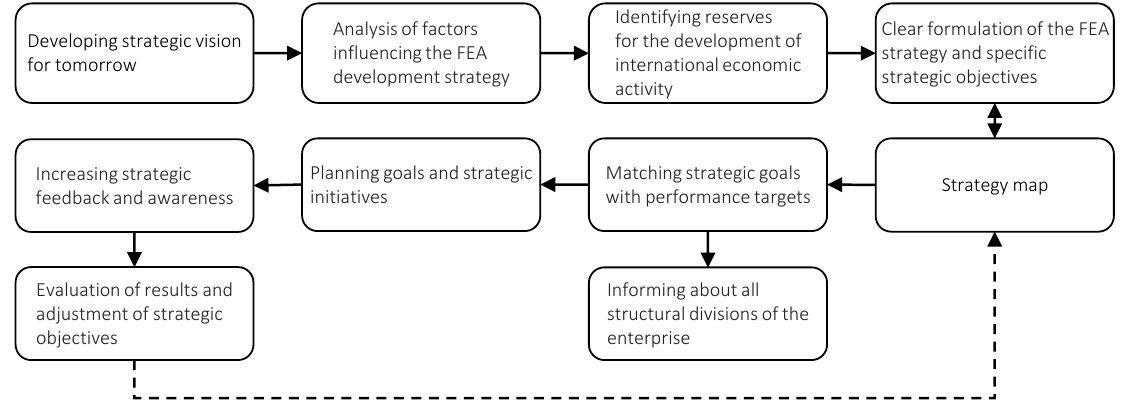
Figure 2. Stages of modeling and implementing the enterprise FEA development strategy